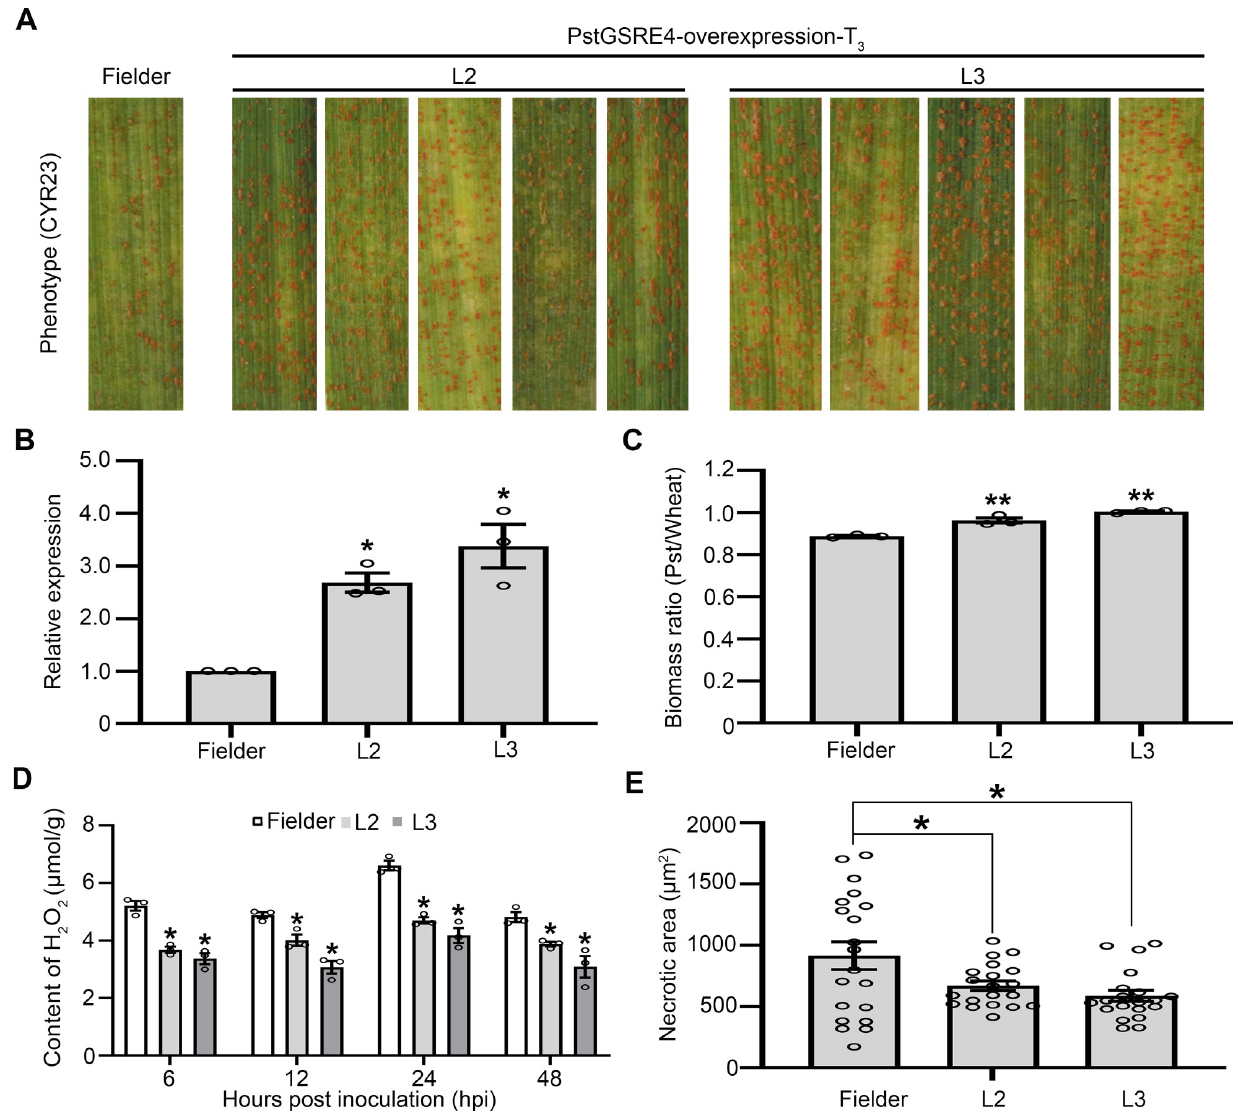
Fig 2. Overexpression of PstGSRE4 significantly increases virulence of Pst and reduces H 2 O 2 accumulation in wheat. (A) Phenotypes of the second leaves of the third generation of wheat plants at 14 dpi with Pst . (B) Relative transcript levels of PstGSRE4 in different transgenic lines at 48 hpi with Pst . Values represent the means ± SE (n = 3). (C) Ratio of fungal to wheat nuclear content determined using the contents of fungal PstEF1 and wheat TaEF-1 α genes, respectively. Genomic DNA was extracted from the second leaf from three different plants at 14 dpi. Values represent the means ± SE (n = 3). (D) Content of H 2 O 2 in different transgenic lines at 6, 12, 24 and 48 hpi. Values represent the means ± SE of three independent samples. (E) Quantification of necrotic cell death area in different transgenic lines at 48 hpi. Values represent the means ± SE (n = 20). Differences were assessed using Student’s t -test. Asterisk indicates P < 0.05, and double asterisk indicates P <